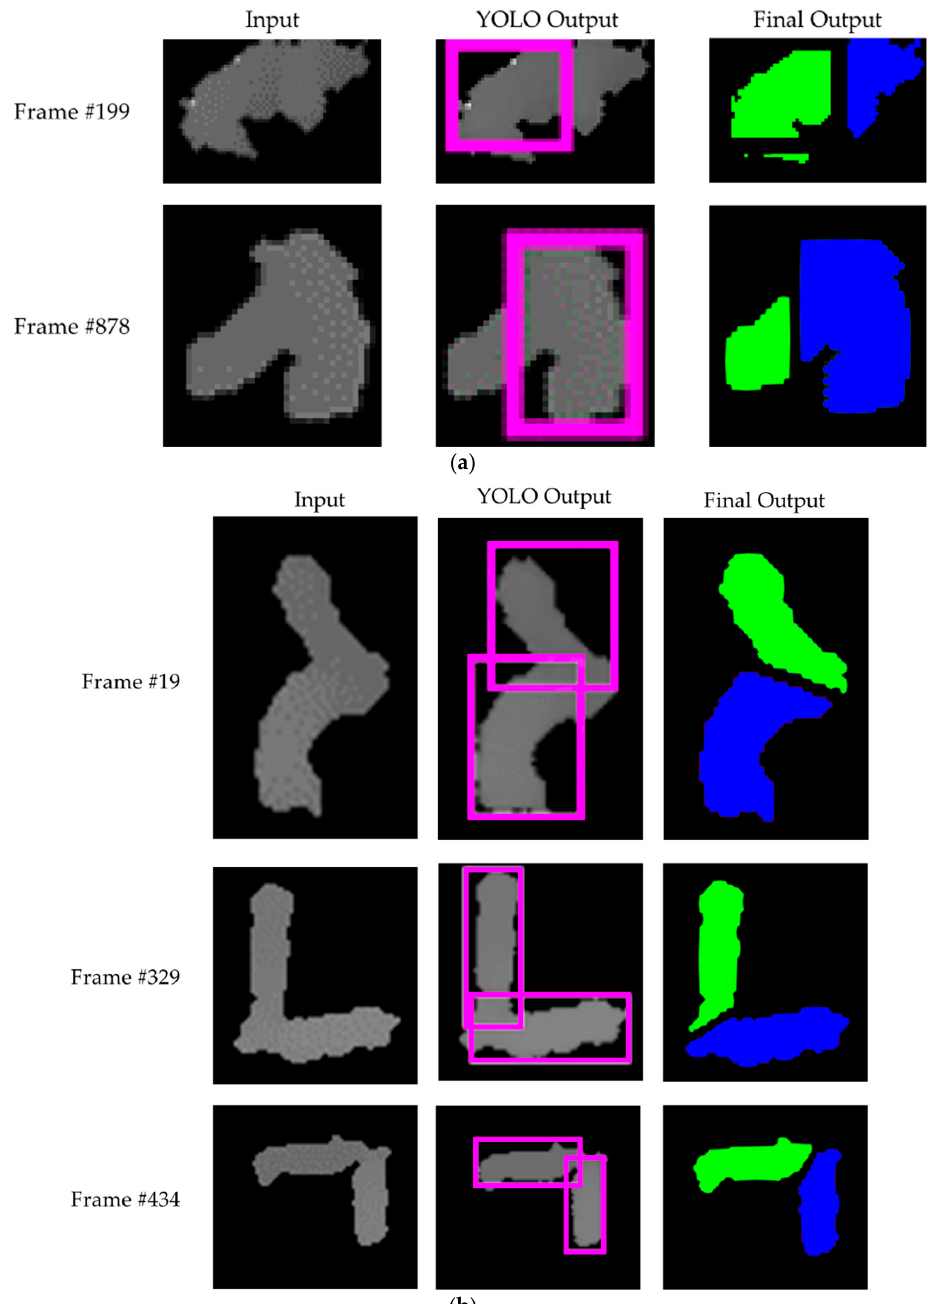
Figure 16. Separation results with YOLO Processing Module: ( a ) separation with a single useful BB; ( b ) separation with two useful BBs.